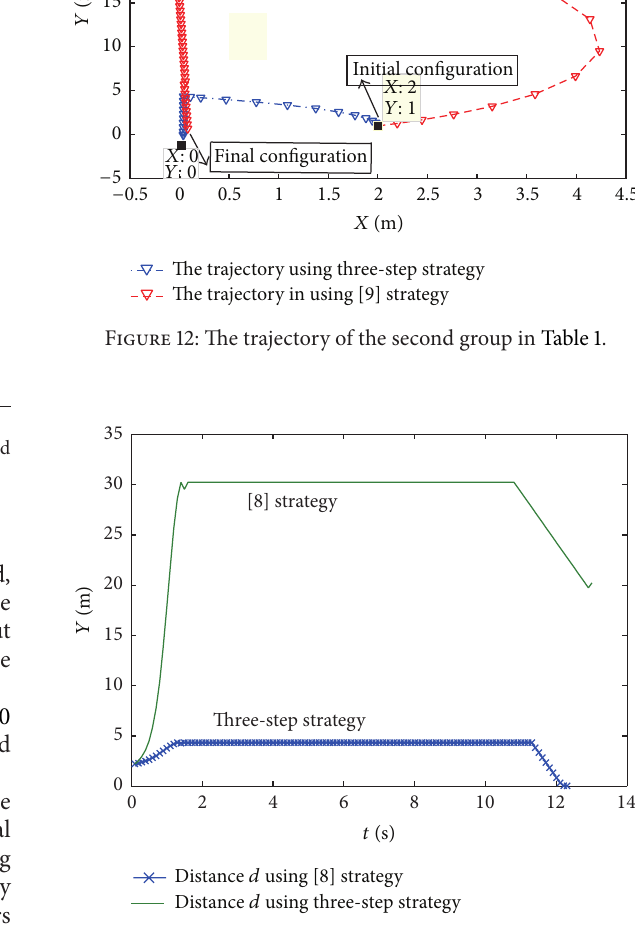
Figure 13: The simulation time is 13s; the distance between the current configuration and the desired configuration of the second group in Table